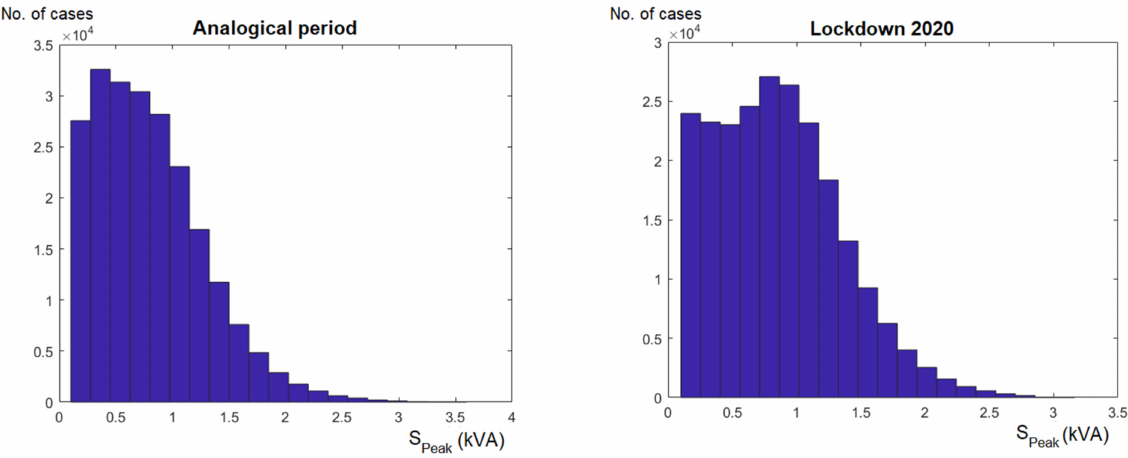
Figure 6. Histograms of the apparent peak loads during the lockdown and analogous period in 2018.